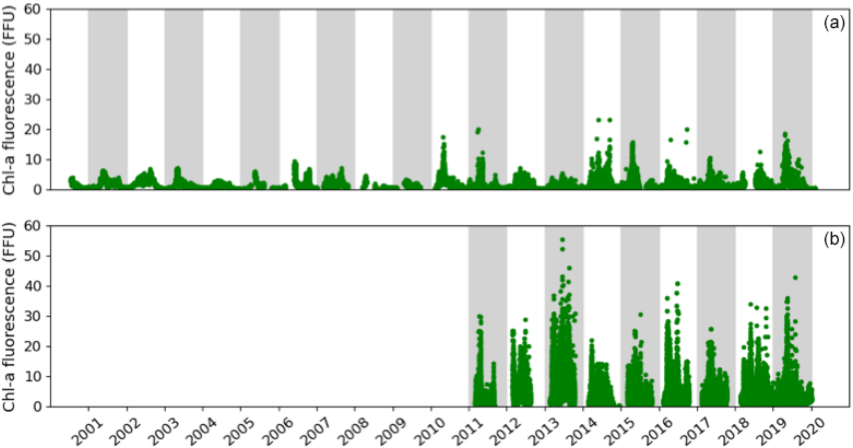
Figure 4. Temporal changes in the in situ Chl a fluorescence measured in the Bay of Brest (a) and the Bay of Vilaine (b) . Table 3. Cluster group assigned to each annual phytoplankton growing period at both sites. The “–” dash represent years with missing data. The cross represents the year 2013 of the Bay of Vilaine, which was not considered.